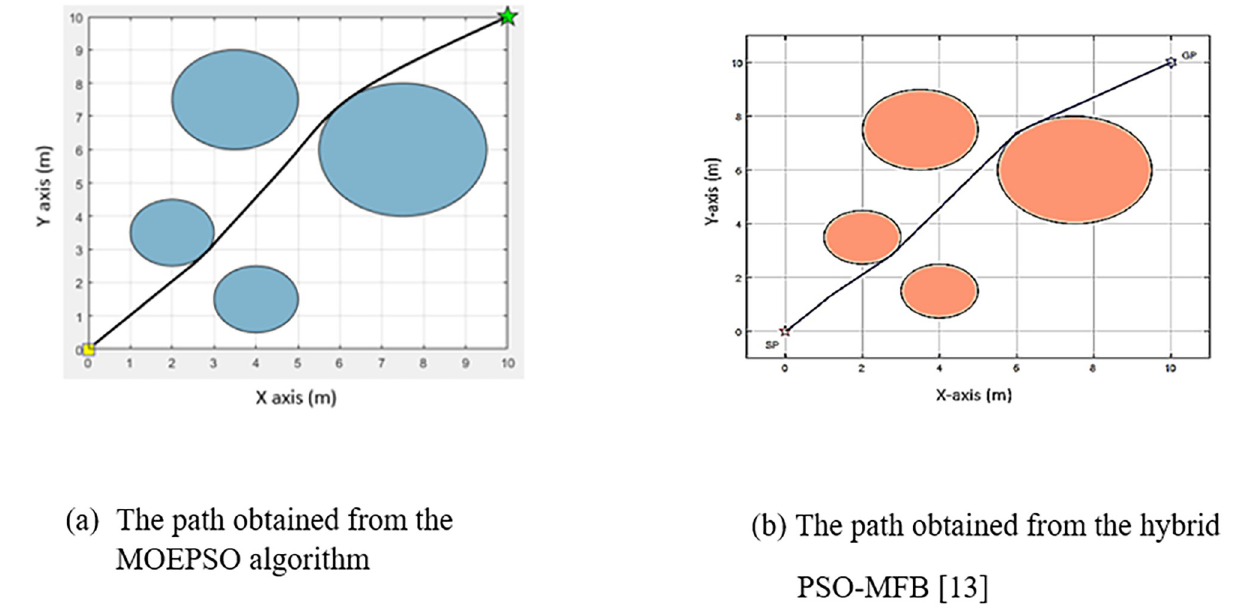
Fig 29. A comparison of the paths obtained from the MOEPSO and the hybrid PSO-MFB [12].